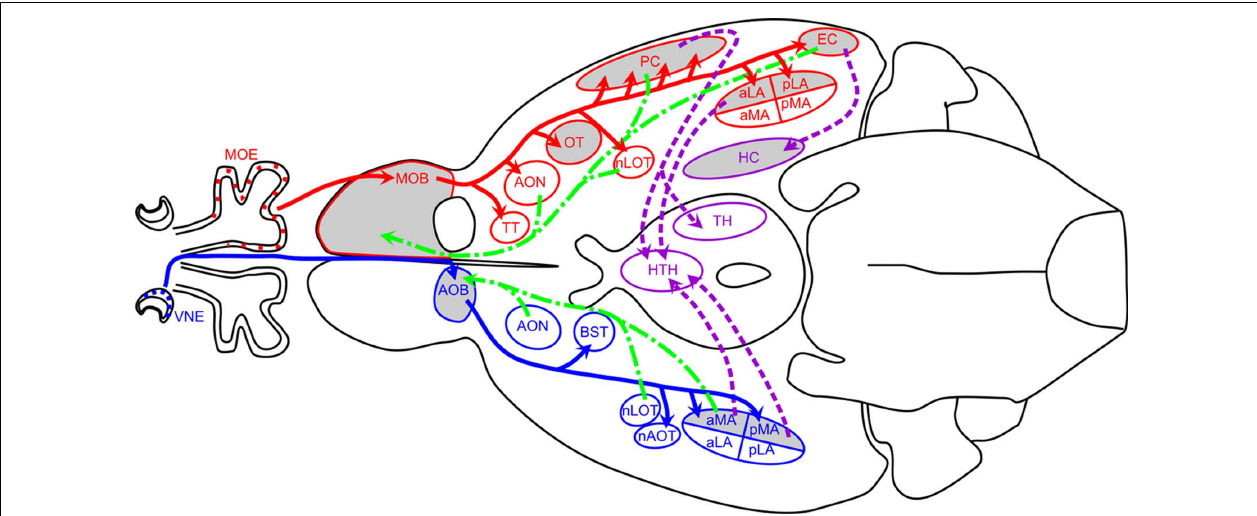
nucleus of the stria terminalis; EC, entorhinal cortex; HC, hippocampus; HTH, hypothalamus; LOT, lateral olfactory tract; MOB, main olfactory bulb; MOE, main olfactory epithelium; nAOT, nucleus of the accessory olfactory tract; nLOT, nucleus of the lateral olfactory tract; OT, olfactory tubercle; PC, the piriform cortex; pLA, posterior lateral amygdala; pMA, posterior medial amygdala;TH, thalamus;TT, tenia tecta;VMH, ventromedial hypothalamus; VNE, vomeronasal epithelium.